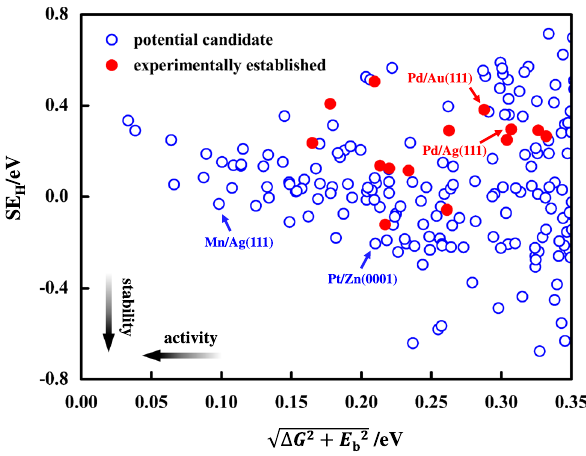
Fig. 4 Stability vs. activity map for fl at SAACs surfaces at T = 298 K and p = 1 atm. The SE y -axis represents stability and activity parameter ffiffiffiffiffiffiffiffiffiffiffiffiffiffiffiffiffiffiffi q H on Δ G 2 þ E 2 is shown on x -axis. Experimentally established SAACs are b denoted with red solid spheres and the blue open circles represent new predicted